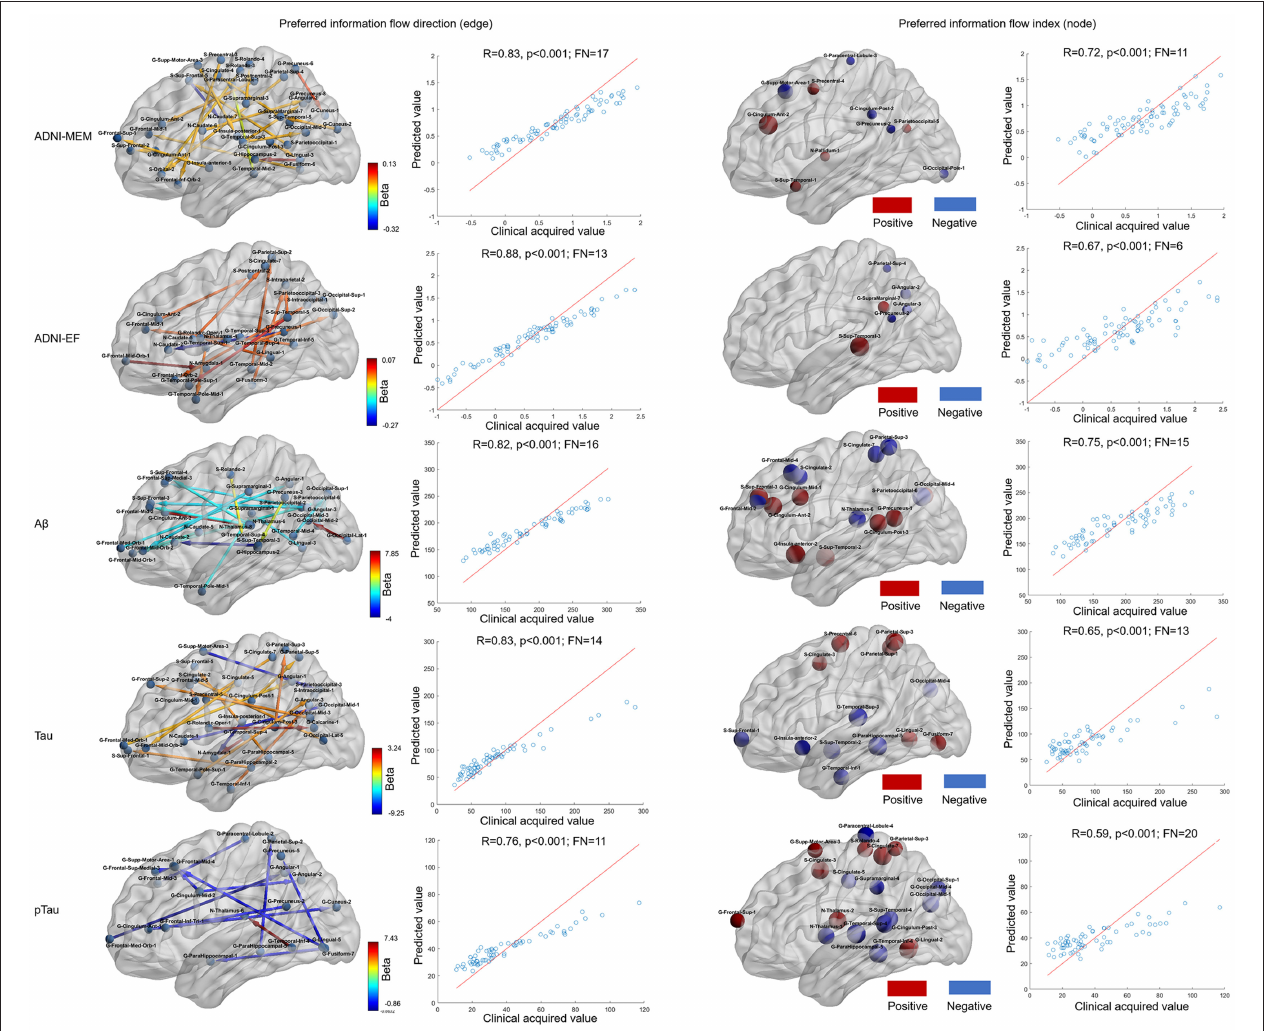
FIGURE 3 | Neurological assessment by using information flow measures by lasso regression. The first and second columns presented the selected information flow directions and a good prediction ability for the ADNI-MEM, ADNI-EF, A β , tau, and pTau evaluation. The color of the directed edge indicated the value of lasso regression coefficient (beta); the third and fourth columns presented the selected information flow index and a relative decreased prediction ability for the ADNI-MEM, ADNI-EF, A β , tau, and pTau evaluation. The size of the node indicated the absolute value of the lasso regression coefficient and the color of the node indicated the positive (red) or negative (blue) lasso regression coefficient. A β , amyloid β ; pTau, phosphorylated Tau; ADNI-MEM, Alzheimer’s Disease Neuroimaging Initiative-composite assessment of memory; ADNI-EF, ADNI-executive function; FN, feature number; G, gyrus; S,